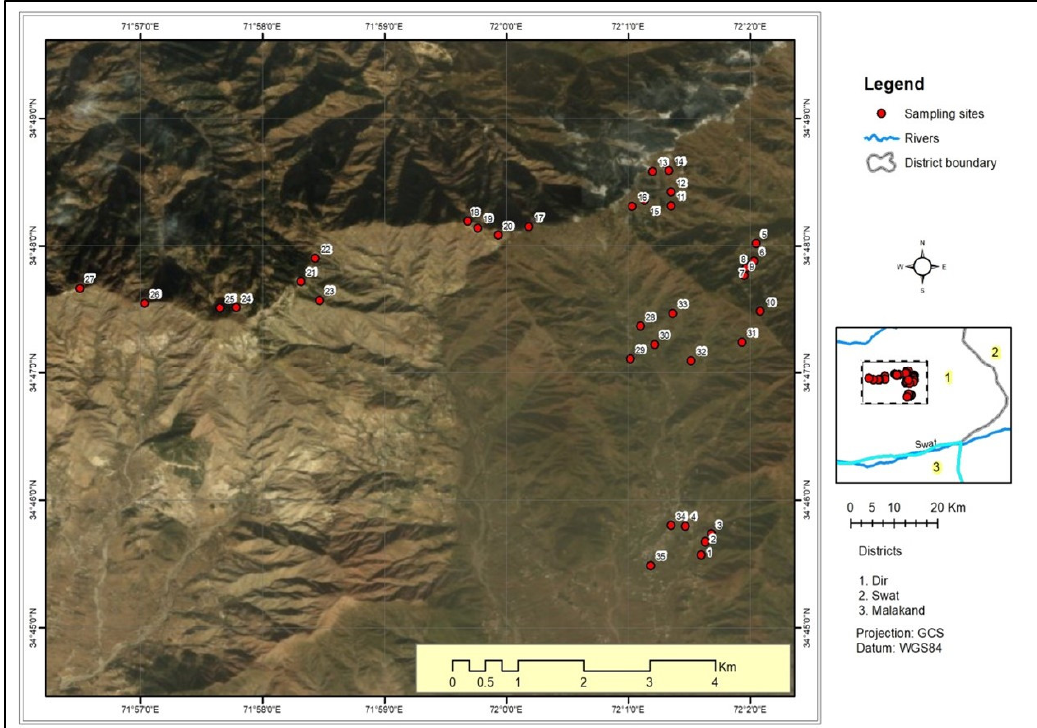
Figure 1. Map of the study area showing sampling points.